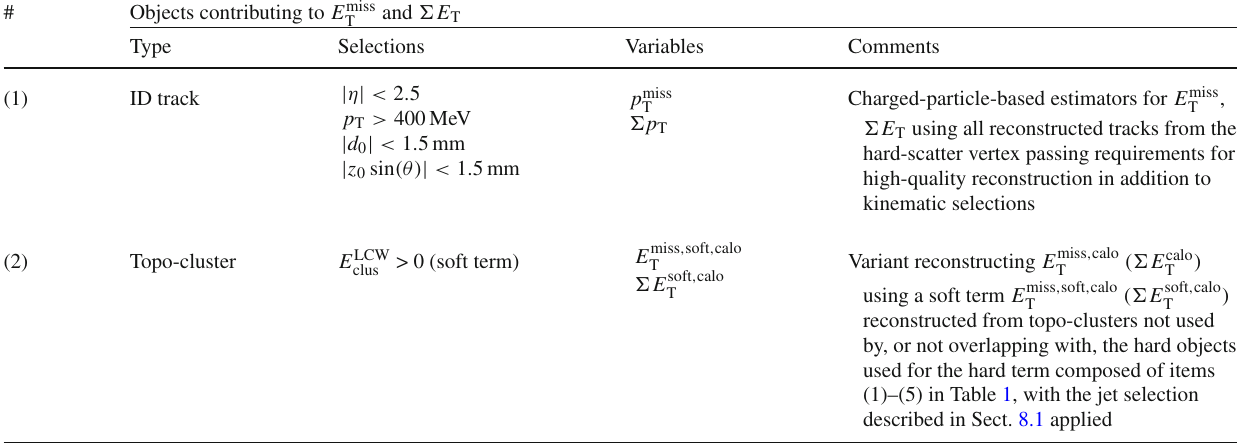
Table 2 Representations of E miss